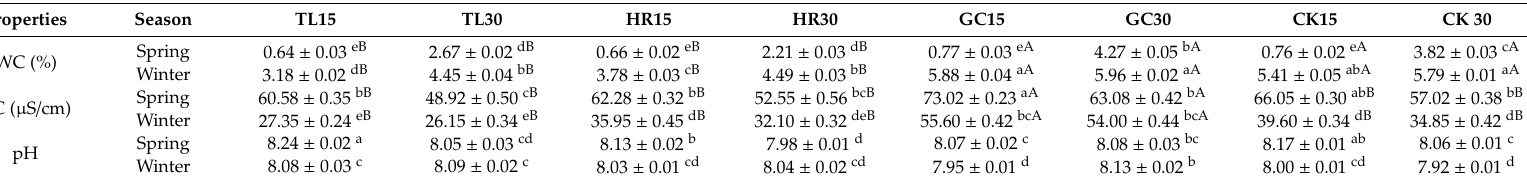
Table 1. Soil physicochemical properties of the